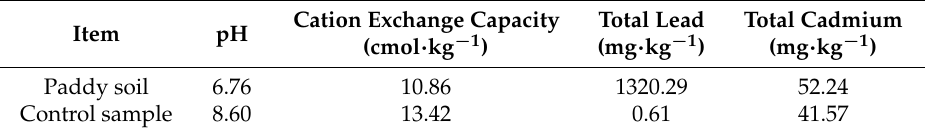
Table 1. The basic properties of the tested soil.